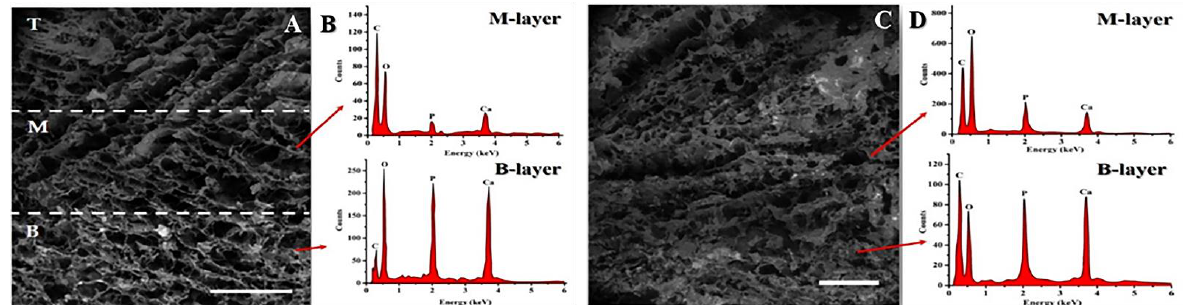
Figure 2. SEM ( A ) and EDX ( B ) of the 3CCO scaffold divided into (B)ottom, (M)edium and (T)op layers. SEM ( C ) and EDX ( D ) of the 3CCO.G scaffold. The frontiers between layers (A) are easy to identify by the changes in the shades of gray. Bar = 1 mm.